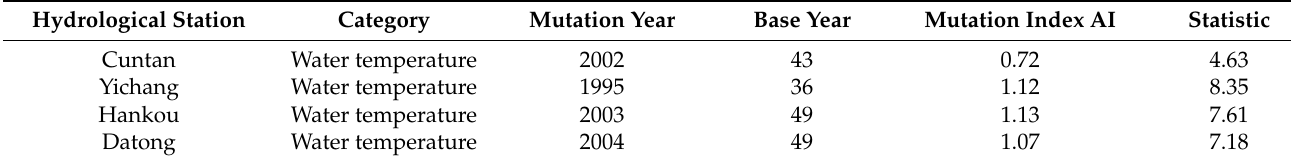
Table 2. The t -test of annual